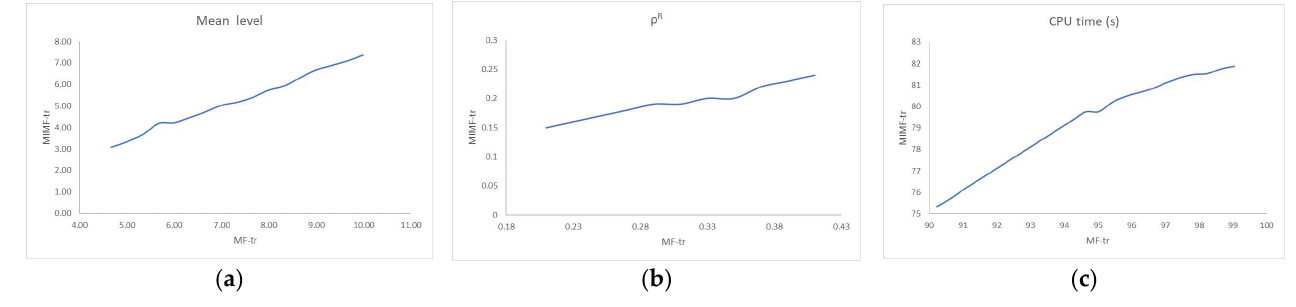
Table 3. Mean levels, PSNR, mean compression rate, and CPU times for the source image in Figure 4a.